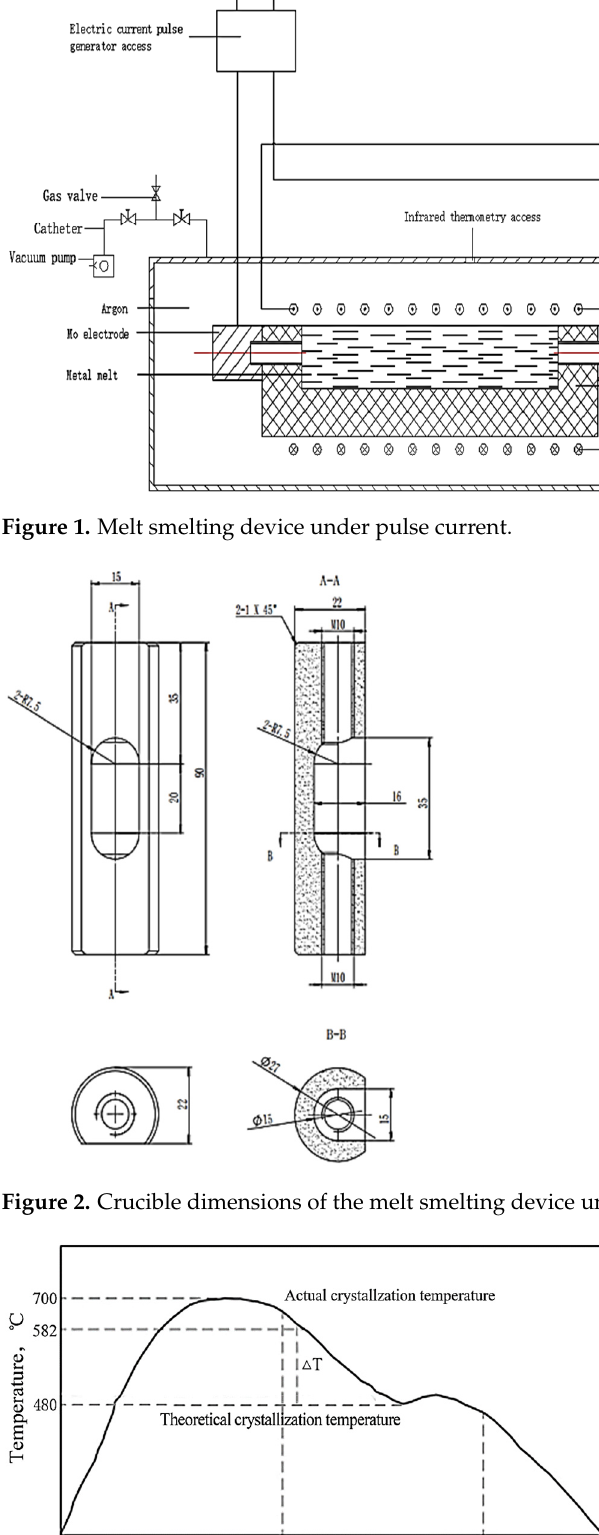
Table 2. Parameters of the pulsed current in this work.